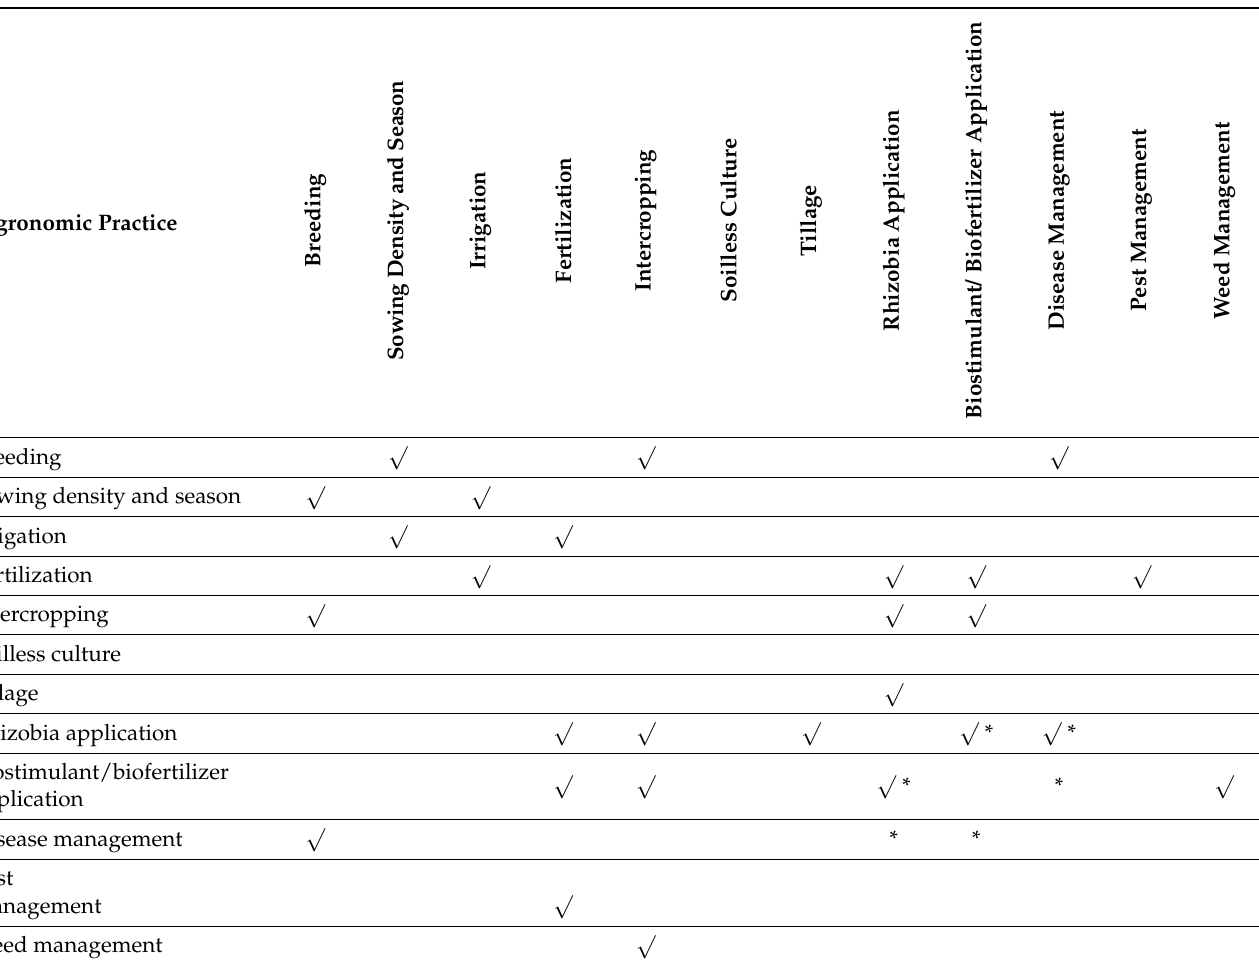
√ denotes the duplicates